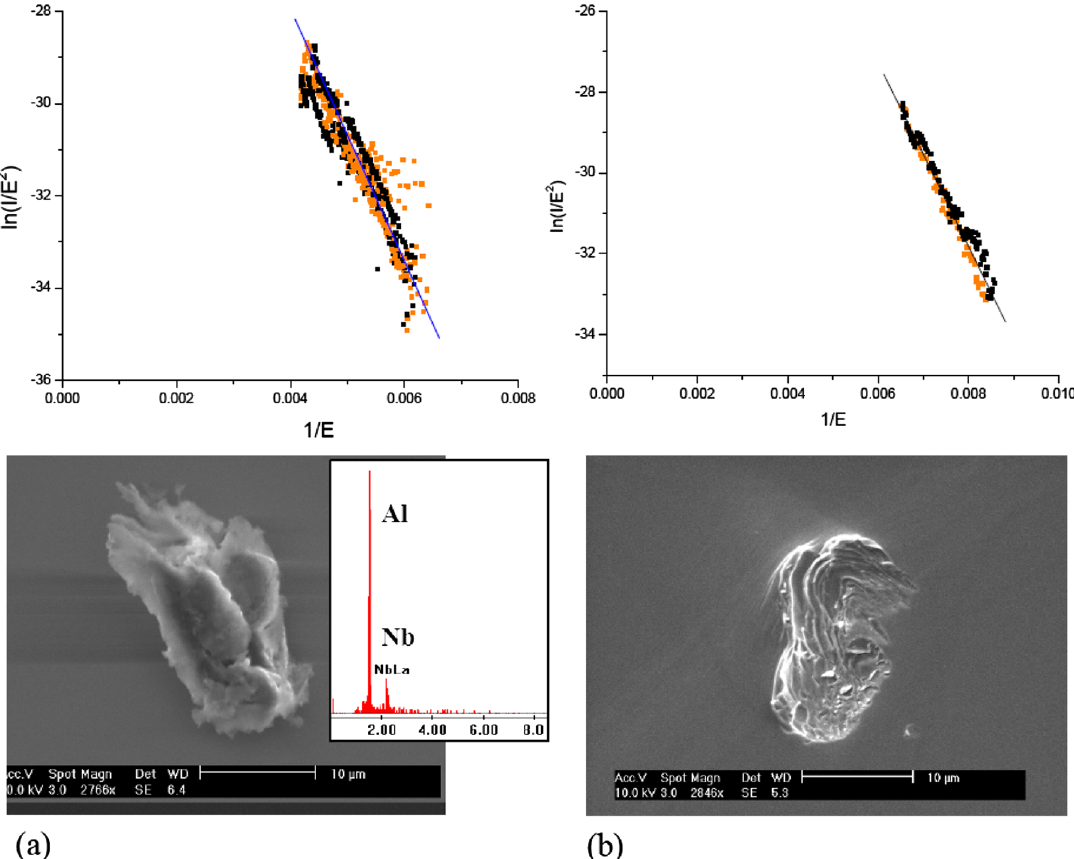
FIG. 5. (Color) I-V curves as FN plots of two emitters measured locally in FESM and corresponding SEM images (a) on SCNb7, showing an Al particulate, and (b) on SCNb4, a surface irregularity. In the plots, unit of I is A and of E is MV = m ; measurement points (orange dots) are for increasing E, and (black dots) for decreasing